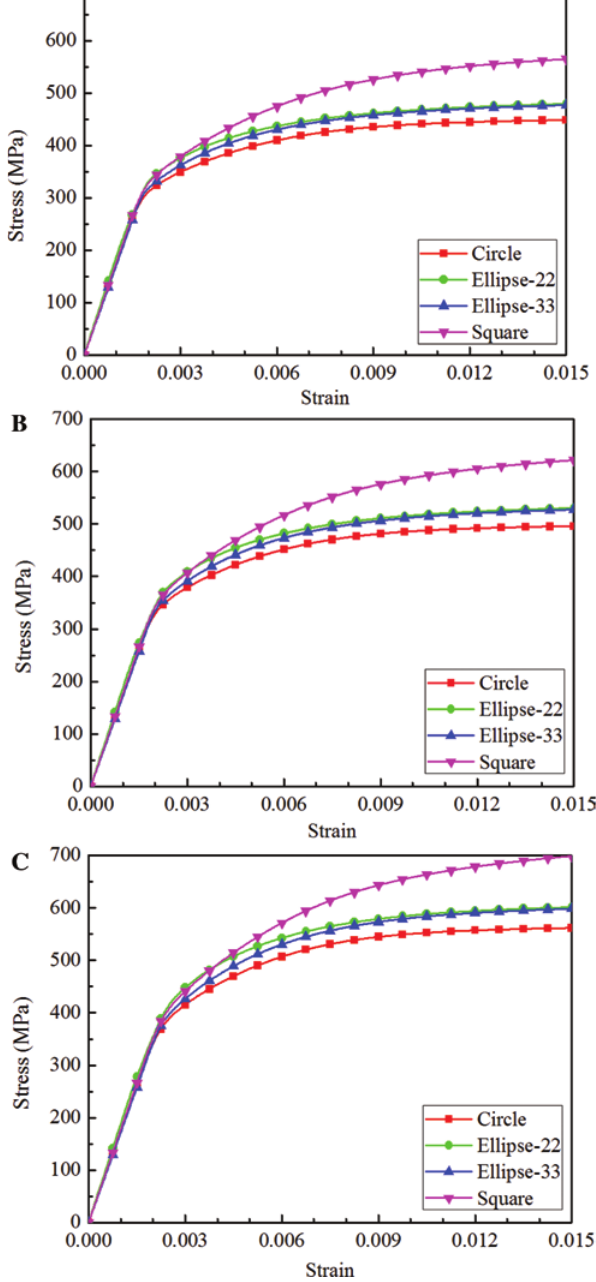
Figure 13: Transverse response of MMCs with square, elliptical and circular fibers at strain rates of (A) 0.01/s, (B) 0.1/s and (C) 1/s.